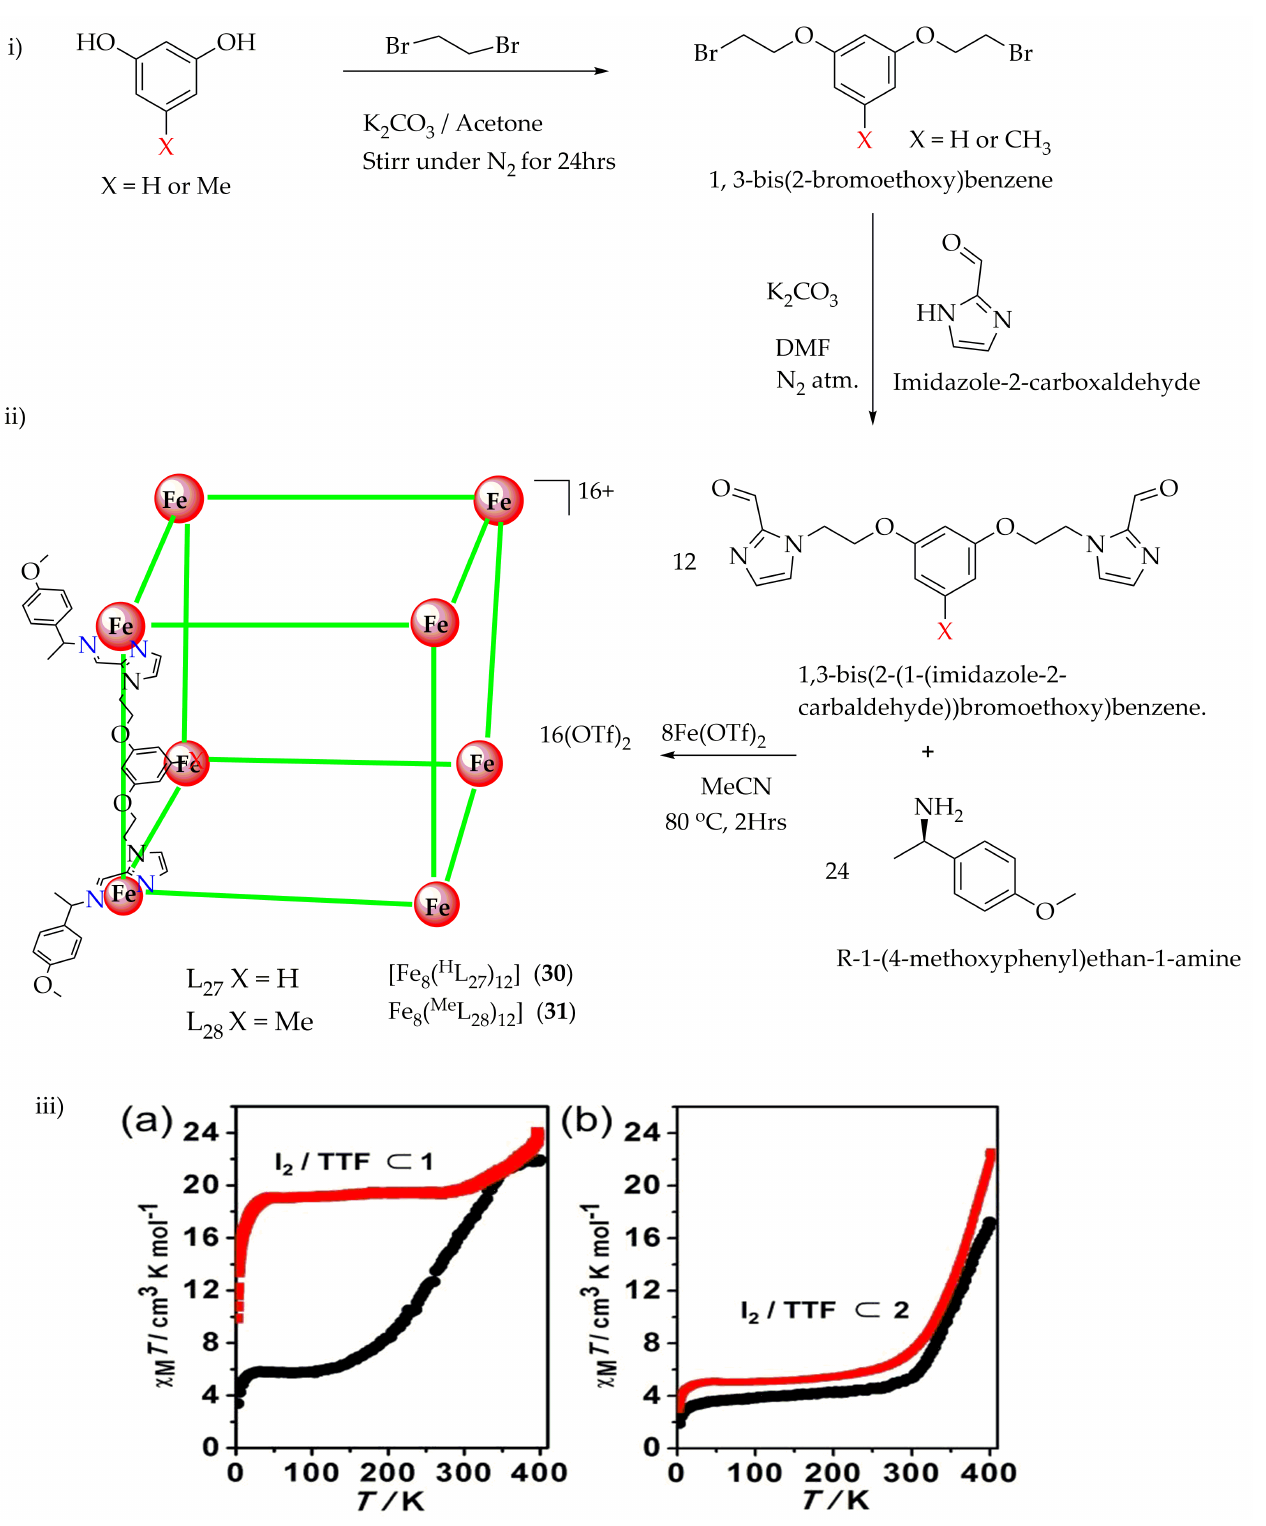
Figure 19. ( i ) Schematic representation for the synthesis of 1,3-bis(2-(1-(imidazole-2- carbaldehyde))bromoethoxy)benzene; ( ii ) schematic self-assembly of cubic cages of complexes 30 and 31; ( iii ) χ M T vs. T of cubic cages of ( a ) [Fe 8 ( H L 27 ) 12 ] black line and [I 2 /TTF@{Fe 8 ( H L 27 ) 12 }] red line ( b ) Fe 8 ( Me L 28 ) 12 ] black line and [I 2 /TTF@{Fe 8 ( Me L 27 ) 12 }] red line. Reproduced with permission from [110]; Published by Royal Society of Chemistry,